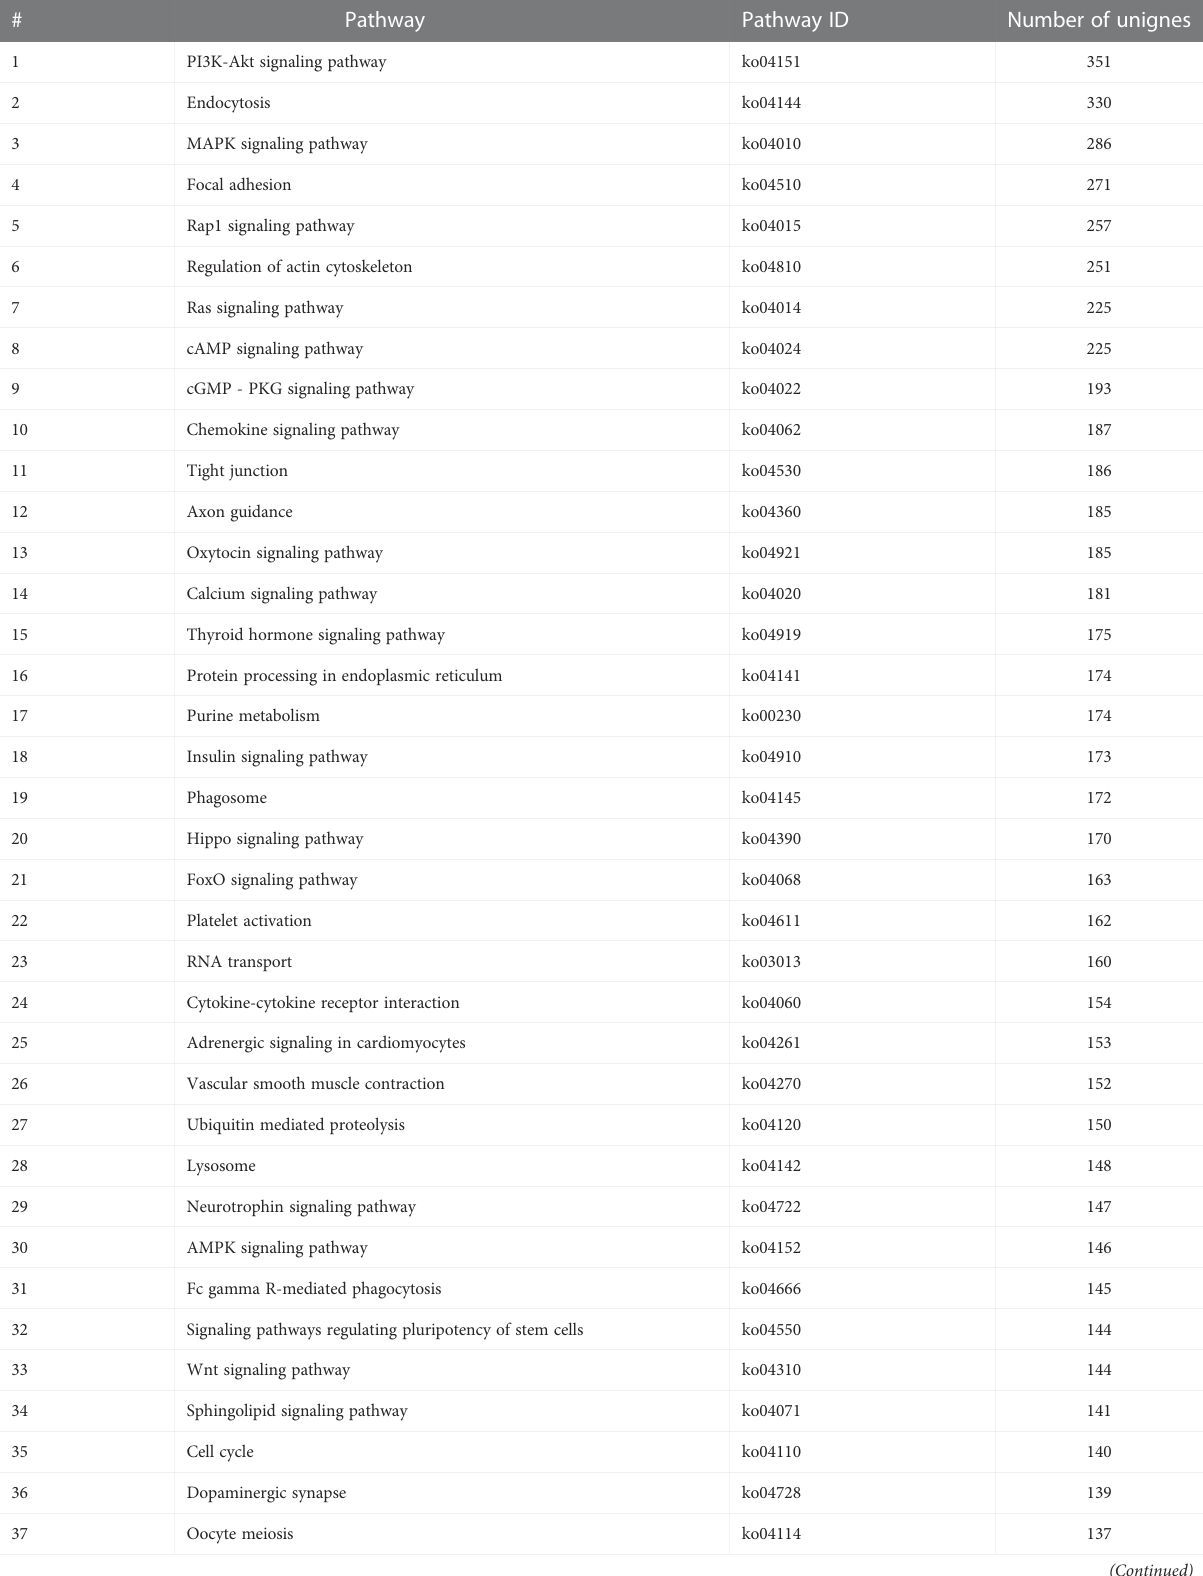
TABLE 5 KEGG annotation of assembled